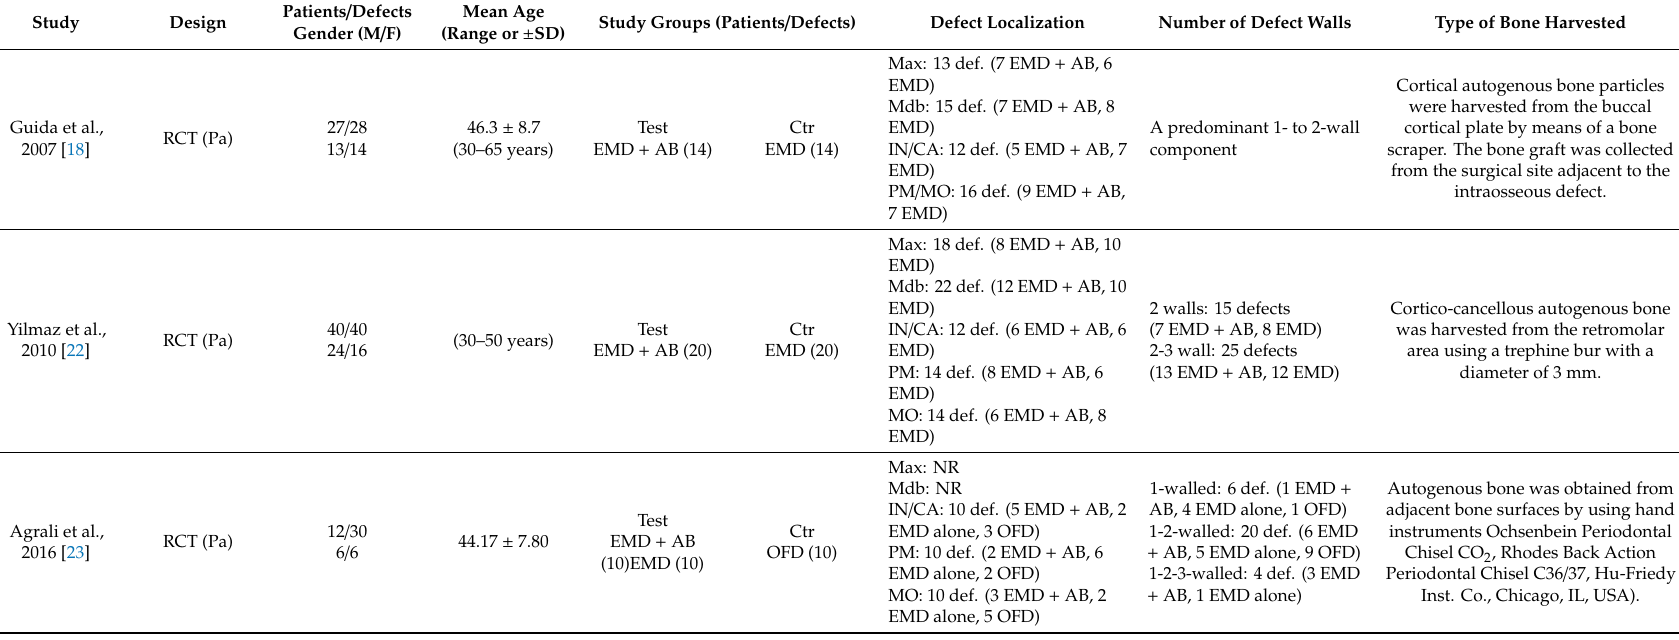
Table 1. Main characteristics of the selected studies: study